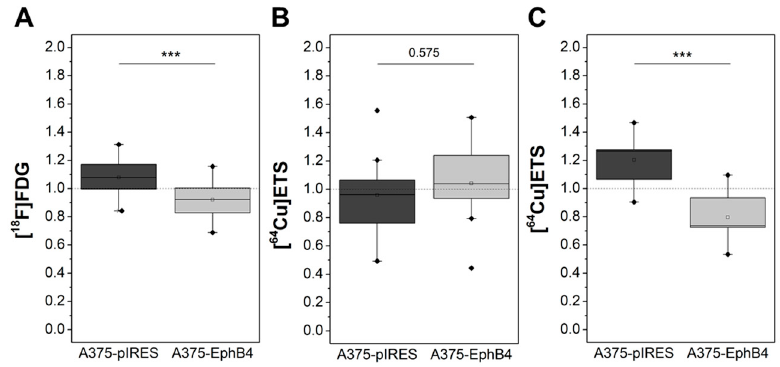
Figure 4. Overexpression of EphB4 in A375 melanoma cells decreases perfusion of tumor xenografts as determined by small animal PET imaging and subsequent ex vivo radioluminography after i.v.